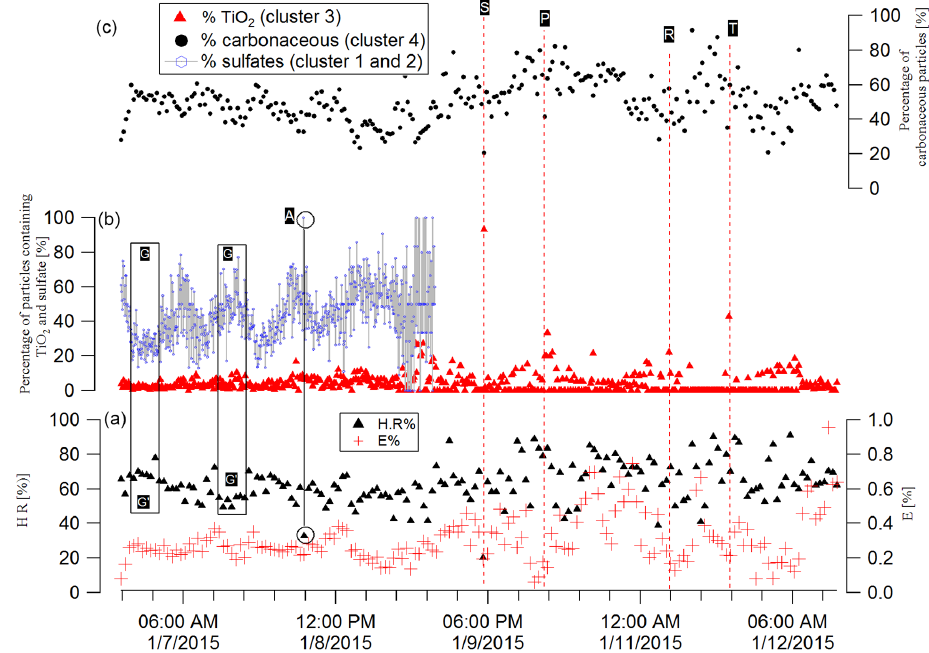
Figure 10. (a) The scattering laser E (%) and the evolution of the hit rate HR (%) of the LAAP-ToF-MS for particles having a size between 400 and 500nm. (b) The evolution of the sulphate particles and the particles containing TiO 2 . (c) The evolution of the elemental carbon particles. A , G and G (cid:48) represent the influence of the percentage of sulphate containing particles on the HR (%). S corresponds to the maximum concentration of TiO 2 and very low values of scattering efficiency and hit rate. P , R and T represent the influence of the percentage of carbonaceous particles on the scattering